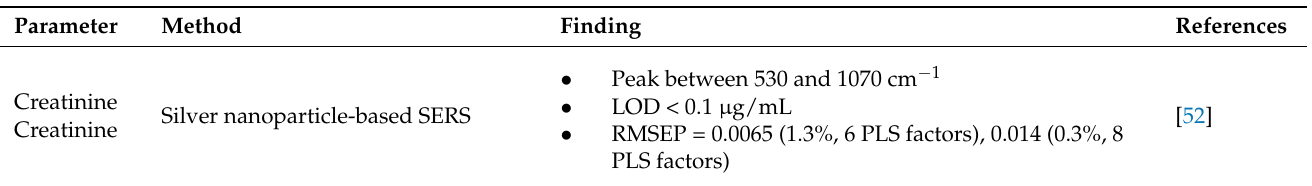
Table 2. Research into the use of Raman spectroscopy (RS) and surface-enhanced Raman spectroscopy (SERS) to measure serum creatinine and